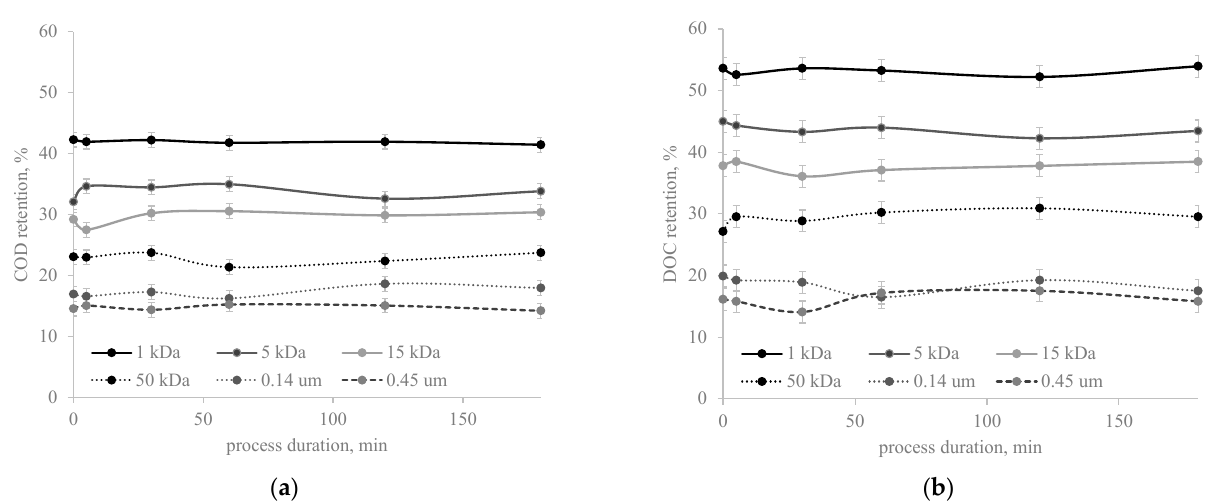
Figure 5. Influence of membrane filtration time on the reduction efficacy of COD ( a ) and DOC ( b ) during digestate liquid fraction treatment (TMP 0.2 MPa).